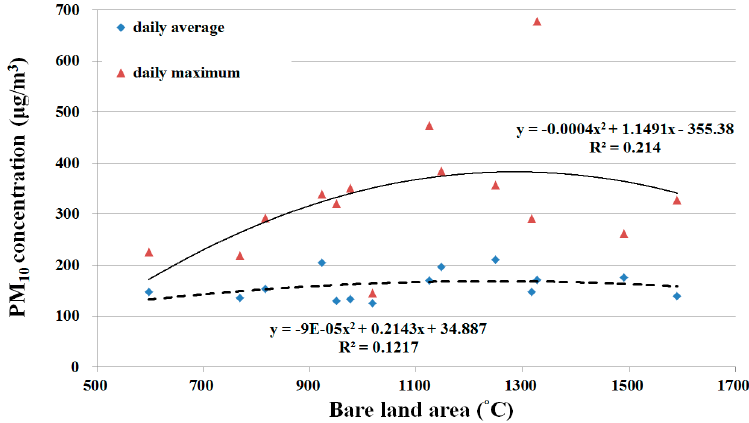
Figure 11. Relationship between daily average/maximum PM 10 and bare land area. Dashed line is regression line of daily average PM 10 and bold line is regression line of daily maximum PM 10 .